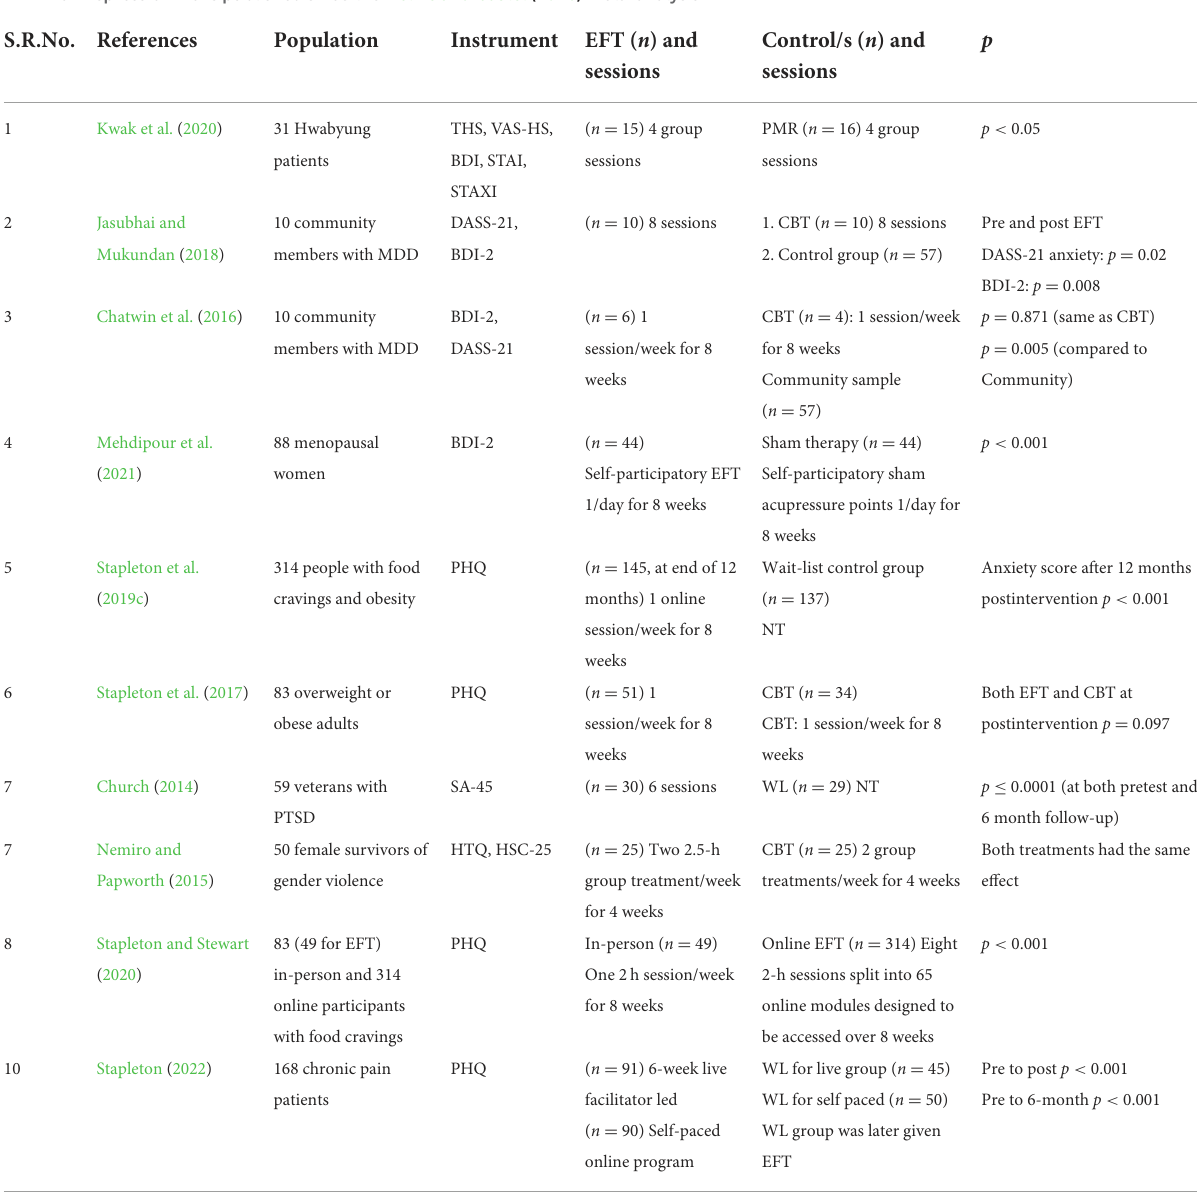
TABLE 5 Depression RCTs published since the Nelms and Castel (2016)